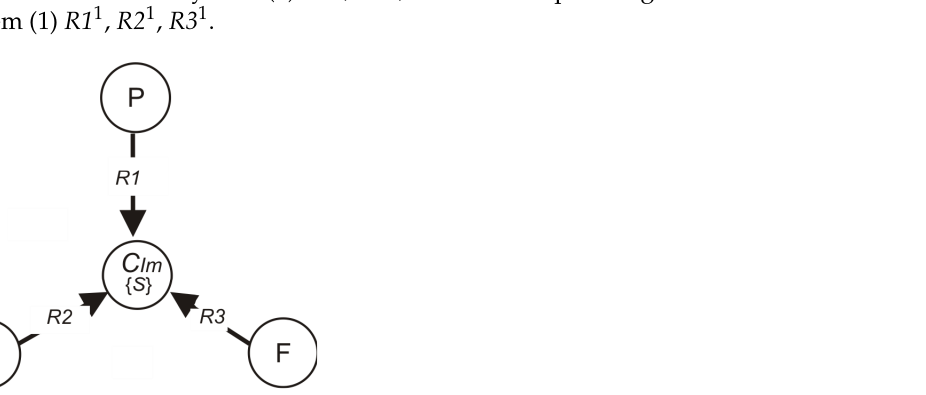
Table 1. Coding of immunogram indicators.